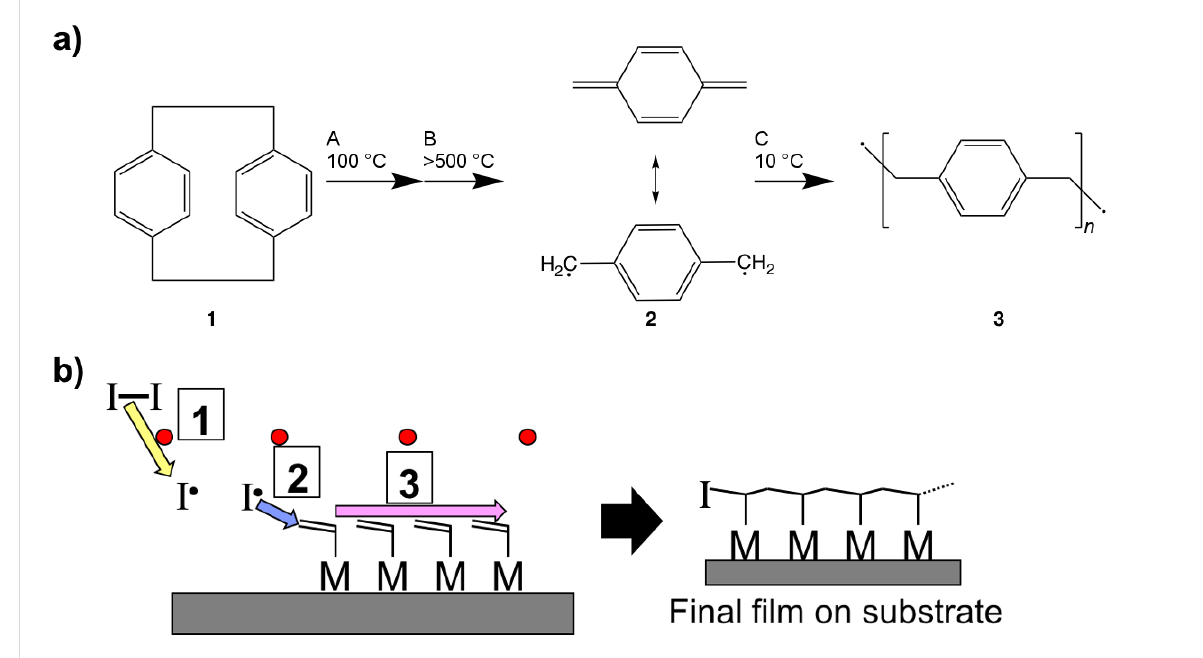
Figure 2: a) Mechanism of parylene CVD. (1) [2,2]paracyclophane (2) p -xylylene diradical intermediate (3) poly[ p -xylene]; A) Sublimation, B) pyroly- sis, C) substrate adsorption. b) Mechanism of iCVD: 1) decomposition of initiator by hot filament, 2) initiator attack of adsorbed monomer, 3) propaga- tion to form polymer